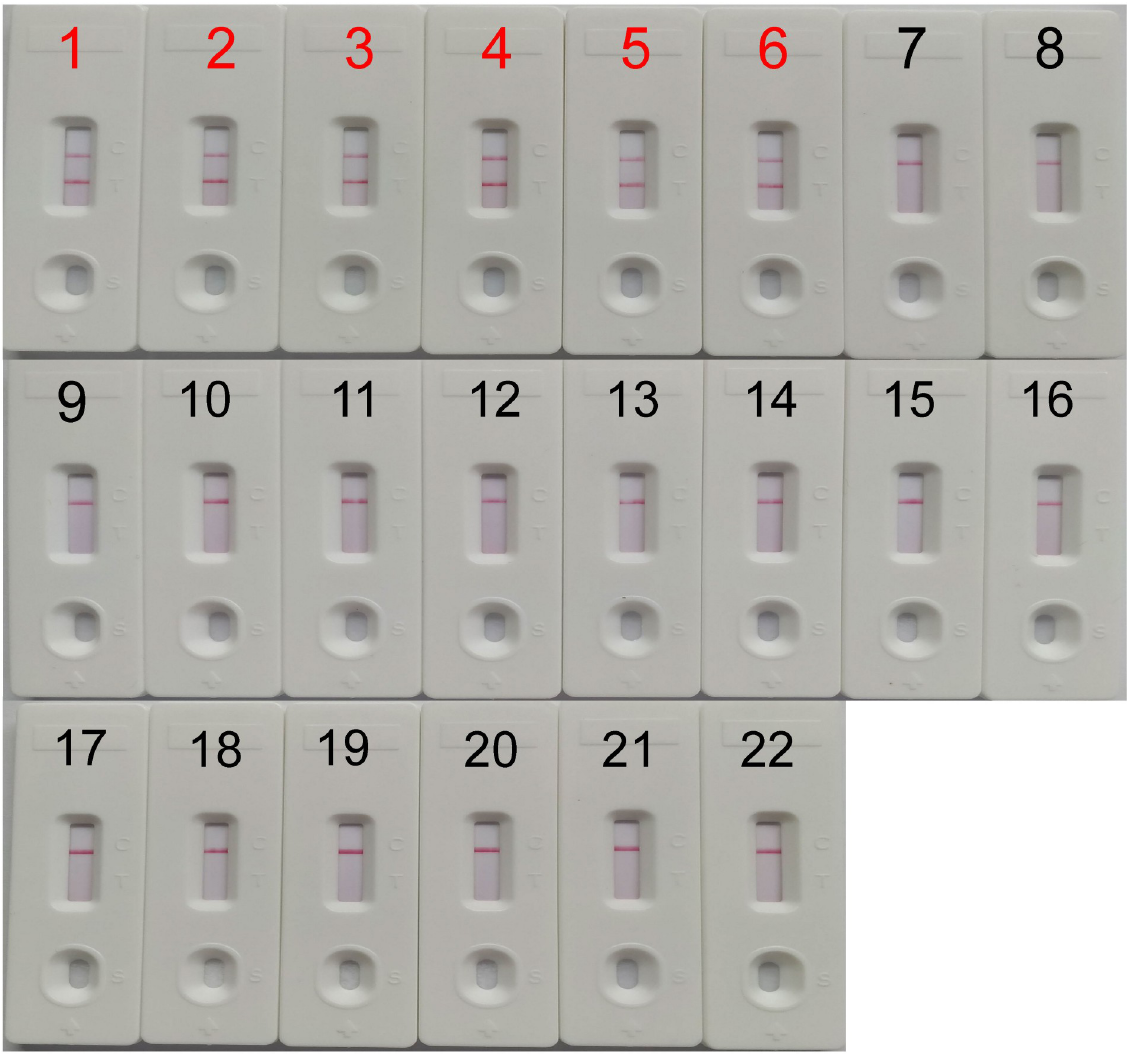
Fig 3. Specificity of the mcr-1 -LAMP-LFB assay. Biosensors 1–6, mcr-1 -positive E . coli WHCDC128, E . coli from WHCDC, E . coli from ICDC, E . fergusonii from ICDC, E . fergusonii from WHCDC, and S . enteritidis from ICDC, respectively. Biosensors 7–14, IMP-4-positive K . pneumoniae , IMP-4-positive E . coli , VIM-1-positive E . cloacae , VIM-2-positive K . pneumoniae , KPC-2-producing K . pneumoniae , KPC- 2-producing P . aeruginosa , KPC-2-producing E . coli , NDM-5-positive K . pneumoniae , respectively. Biosensors 15–21, A . baumannii , P